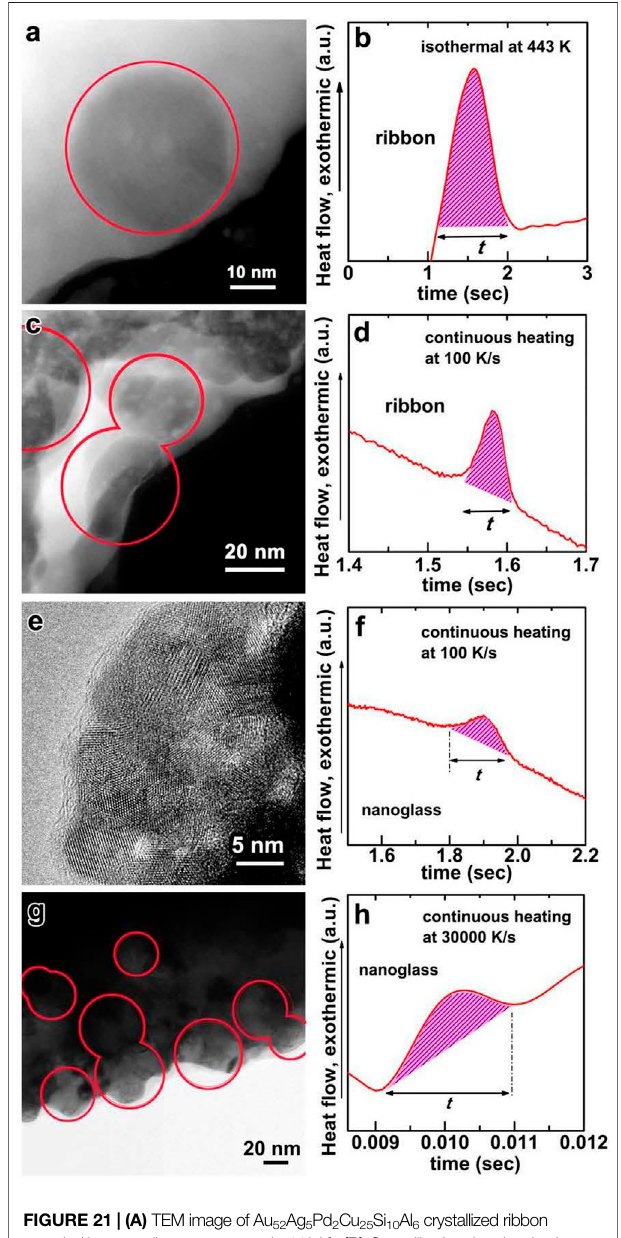
FIGURE 21 | (A) TEM image of Au 52 Ag 5 Pd 2 Cu 25 Si 10 Al 6 crystallized ribbon sample (the annealing temperature is 443 K). (B) Crystallization time last is about 0.9 s based on the corresponding DSC heat fl ow curve. (C) TEM image of Au 52 Ag 5 Pd 2 Cu 25 Si 10 Al 6 crystallized ribbon sample by continuous heating with 100 K/s (D) Crystallization time is about 0.06 s based on the corresponding DSCheat fl ow curveand thepeak temperatureis about 456 K. (E) TEM imageof the crystallized nanoglass samples by continuous heating with 100 K/s (F) Crystallization time is about 0.18 s based on the corresponding DSC heat fl ow curveandthepeaktemperatureisabout488 K. (G) TEMimageofthecrystallized nanoglass by continuous heating with 30,000 K/s (H) Crystallization time is about 1.8 ms based on the corresponding DSC heat fl ow curve and the peak temperature is about 564 K (from (Wang J. Q. et al., 2014)).